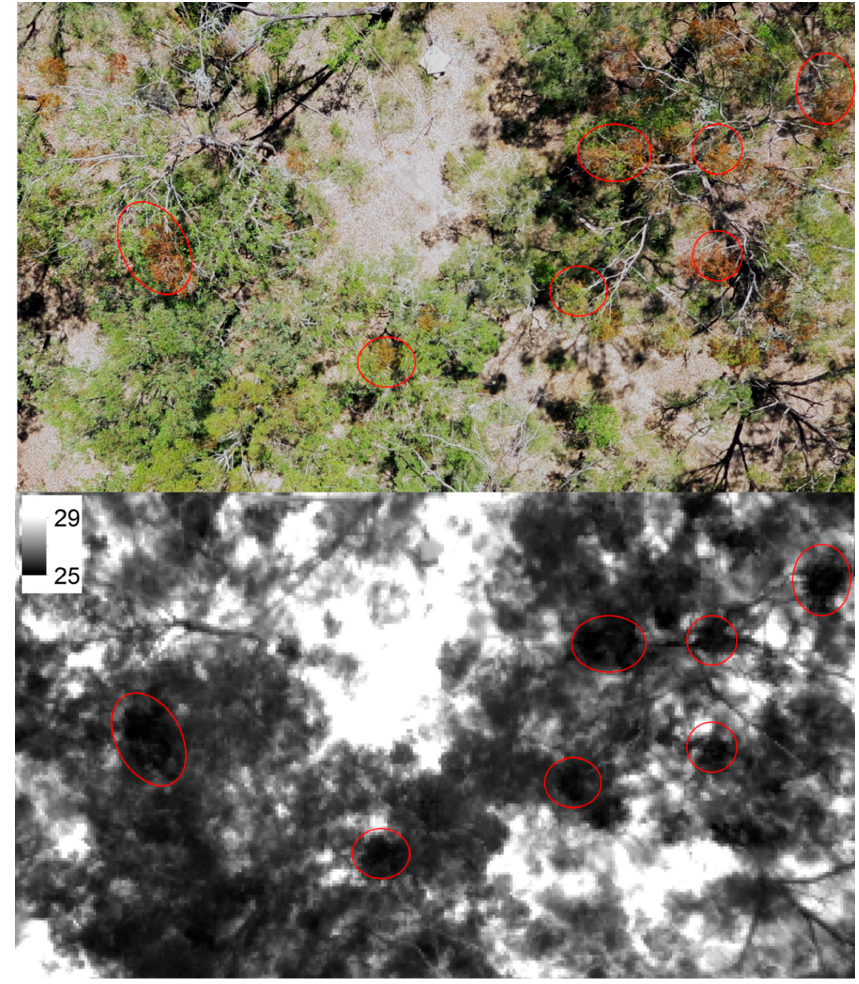
Figure 3. RGB (top) and thermal image (bottom) of trees infected with mistletoe (Indicated with red circles; not all mistletoe infections are indicated). The temperature scale is indicated. The area covered is about 33 by 24 m. Imagery was taken on the flight of 07/02/2014.